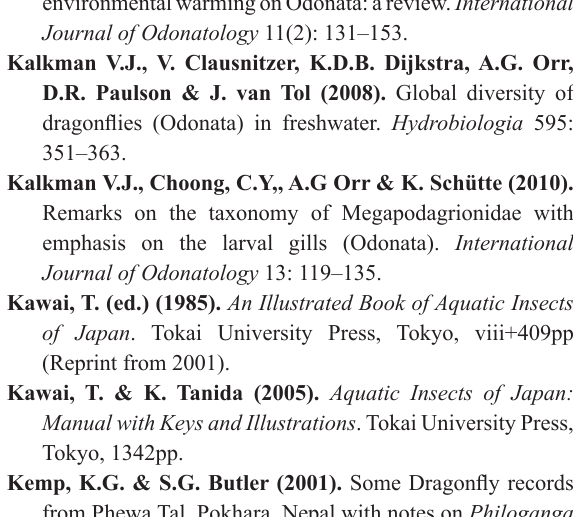
Figure 7. Lestidae [fig. taken: Kawai 1985: 62 (fig. no. 3a), Lestes